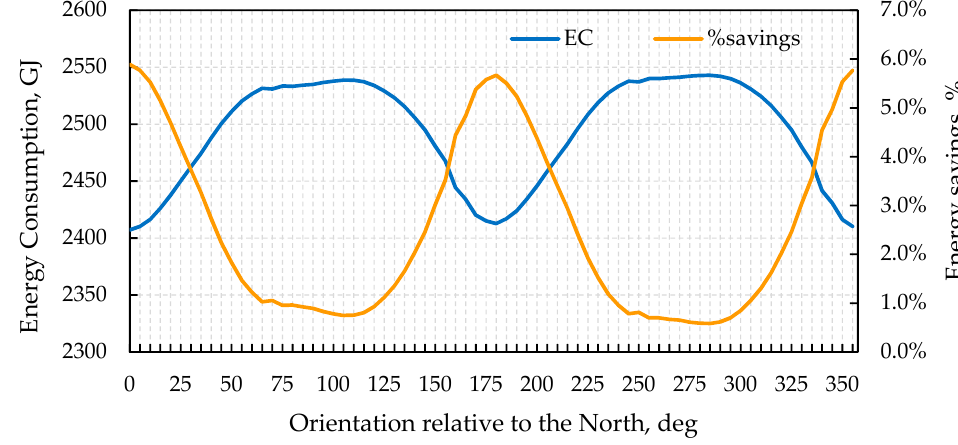
Figure 6. Effect of building orientation on heating and cooling energy demand.